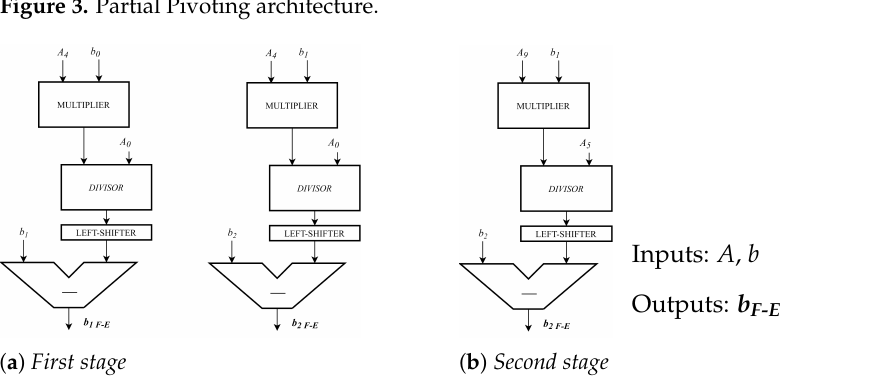
Figure 3. Partial Pivoting architecture.